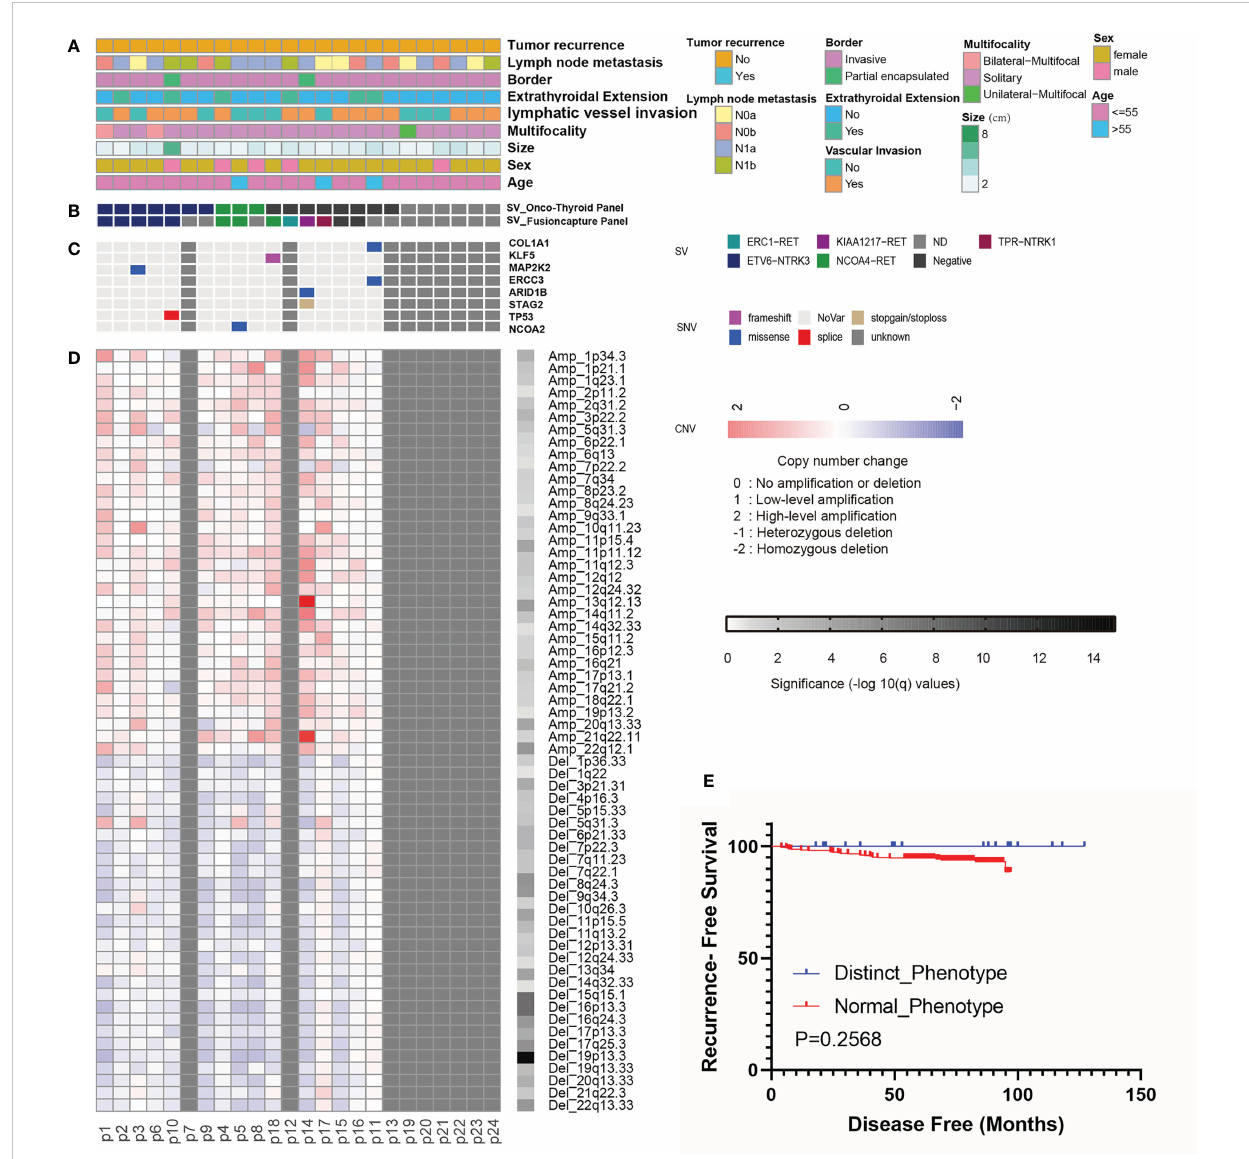
FIGURE 4 Landscape of genomic alterations and Kaplan-Meier analyses in Papillary Thyroid Carcinomas with non-classical phenotype. (A-D) Landscape of genomic alterations (n=24). (A) Tumor recurrence, lymph node metastasis, border, extrathyroidal extension, lymphatic vessel invasion, multifocality, tumor size, patient gender and age. (B) Fusion events detected by Onco-Thyroid Panel and Fusioncapture Panel sequencing. (C) Mutations of driver genes detected by WES. (D) Copy number changes detected by WES. (E) Kaplan-Meier analyses of the impacts of phenotype on recurrence-free survival of PTC patients